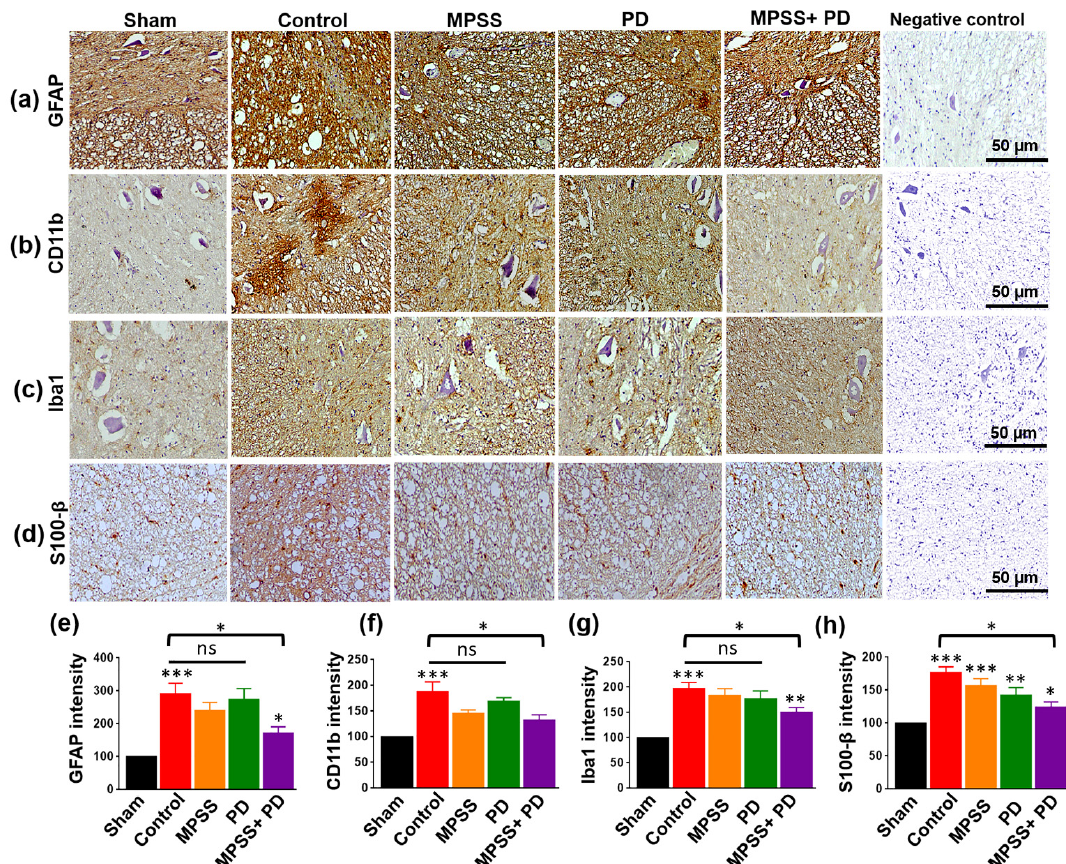
Figure 7. Immunohistochemical assessments of glia inflammatory markers and calcium binding proteins following different treatments after SCI. ( a ) Representative images immunoassayed with glial fibrillary acidic protein (GFAP), and ( b ) CD11b of activated astrocytes and microglia, receptively, of the spinal cord from indicated groups. Strong staining of GFAP and CD11b positive cells was found in the spinal cord lesion of the control group, MPSS and PD150606, while the combination group had a remarkably better inhibitory effect on glia cells activation. Similar results were obtained when ( c ) sections of the spinal cord were stained with the calcium-binding proteins Iba1, and ( d ) S100- β in glial cells. The calcium-binding proteins were increased in all groups; but the combination group remarkably inhibited their upregulation compared to other groups. Scale bare = 50 µm. Negative control for antibody reaction was used where non-specific secondary antibody was used. ( e ) Quantitative analysis of the average GFAP intensity, ( f ) CD11b intensity, ( g ) Iba1 intensity, and ( h ) S100- β intensity in the indicated groups. Ten images from each group were used for data quantification. Data are presented as the mean ± SD. * p <0.05, ** p <0.01, *** p <0.001, and ns indicates non-significant.